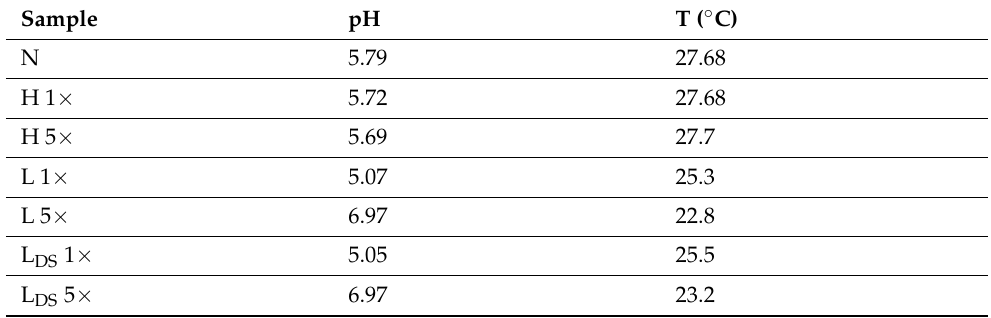
Table 6. pH value of the front surface of whole medical masks before and after washing. Sample